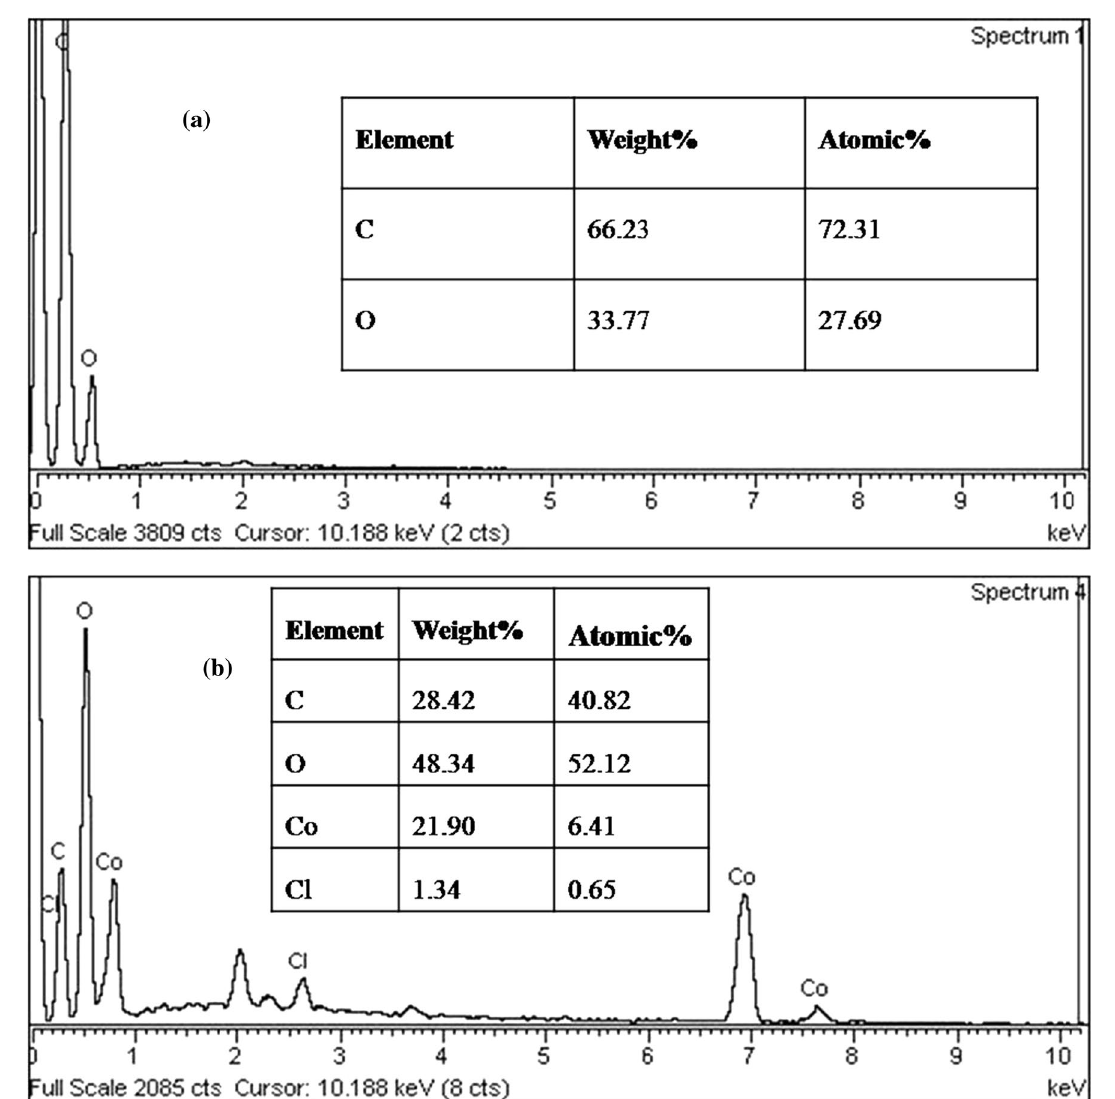
Fig. 4 EDX spectra of chitosan and Co/cross-linked